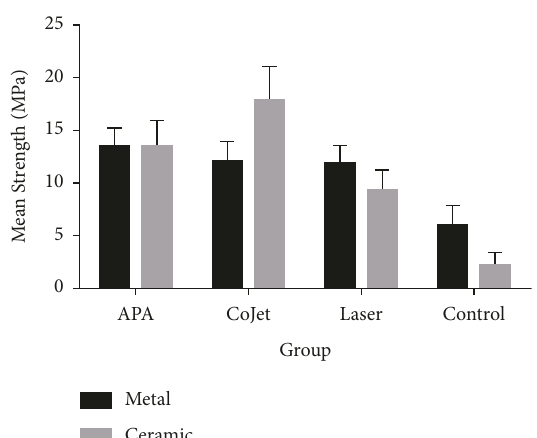
Figure 4: Mean SBS of zirconia (MPa) based on orthodontic bracket type and surface treatment method (APA: airborne-particle